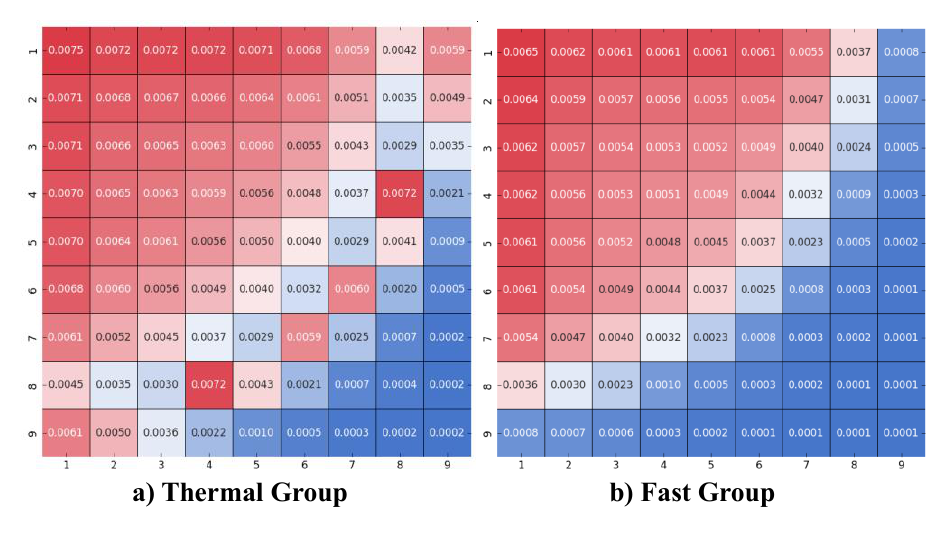
Figure 7. The MAE of flux for each node in the core